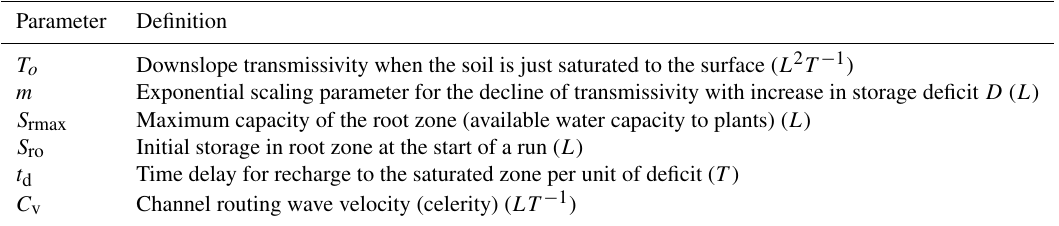
Table 1. Definitions of parameters in the “classical” version of TOPMODEL. Parameter